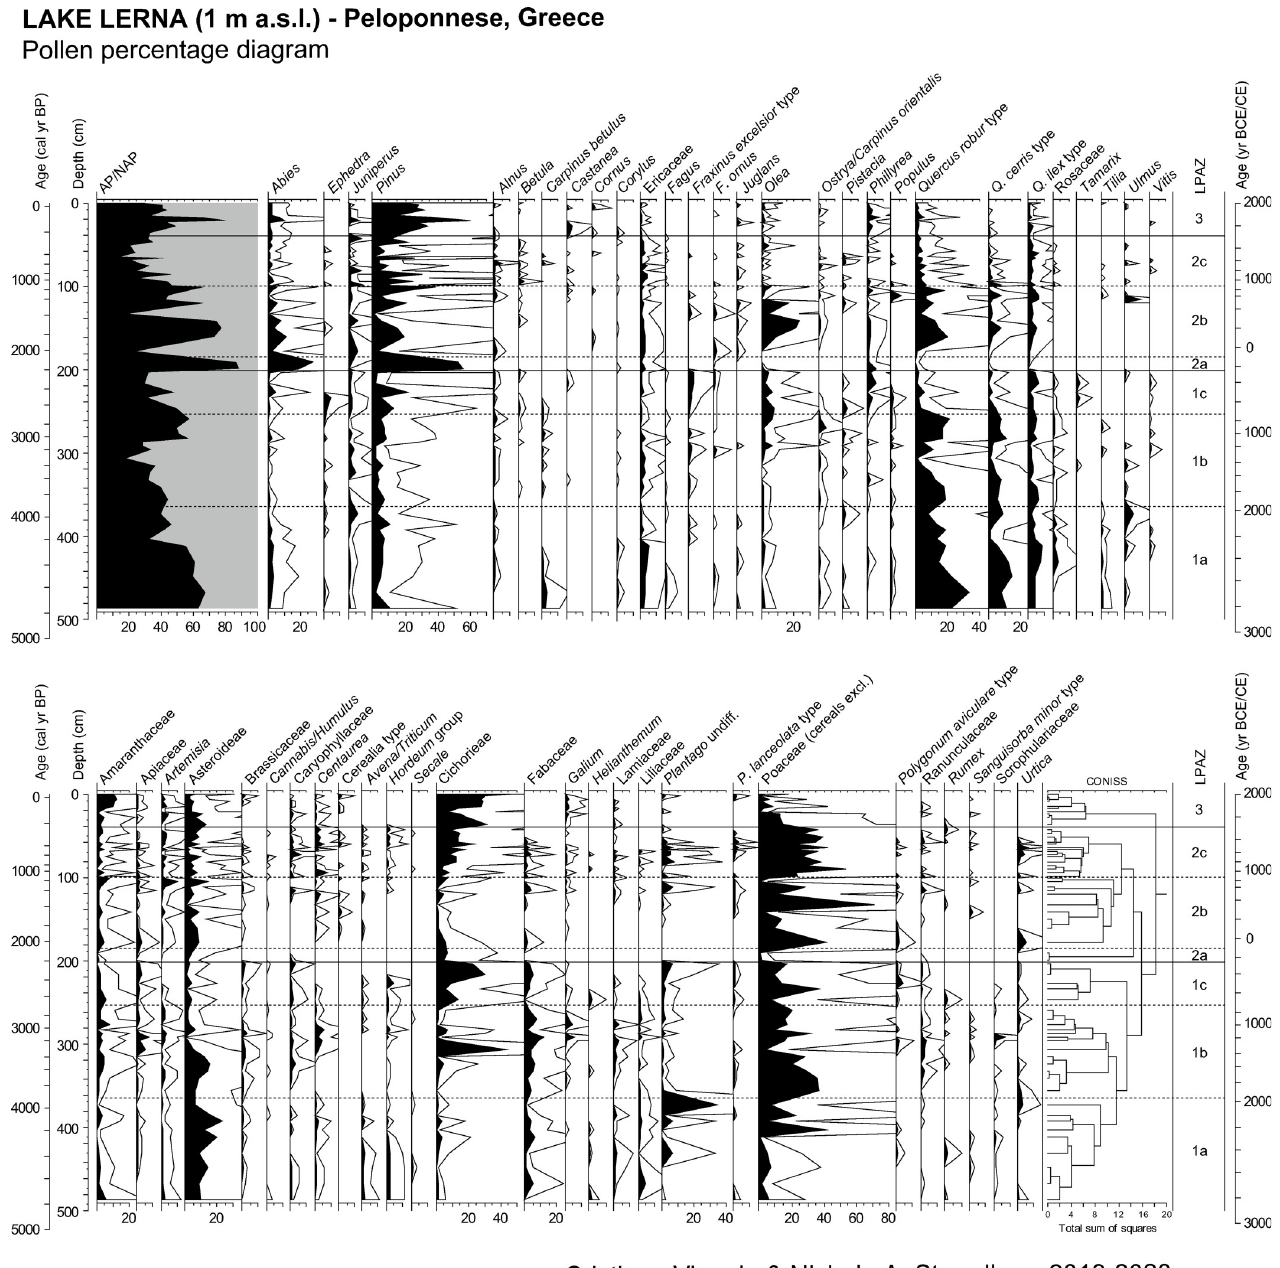
Fig 3. Results of pollen analysis of the study core from ancient Lake Lerna (Peloponnese, Greece). Pollen percentage diagram of arboreal and non-arboreal selected taxa. Curve magnification 4x. Seven pollen zones and sub-zones, named from LPAZ 1a (bottom) to LPAZ 3 (top), are described. Pollen zonation was determined by CONISS cluster analysis and visual inspection. Ages are expressed in calendar years BP and the estimation is rounded up to the nearest 10 years.